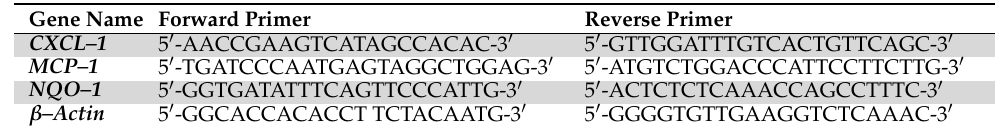
Table 1. The forward and reverse